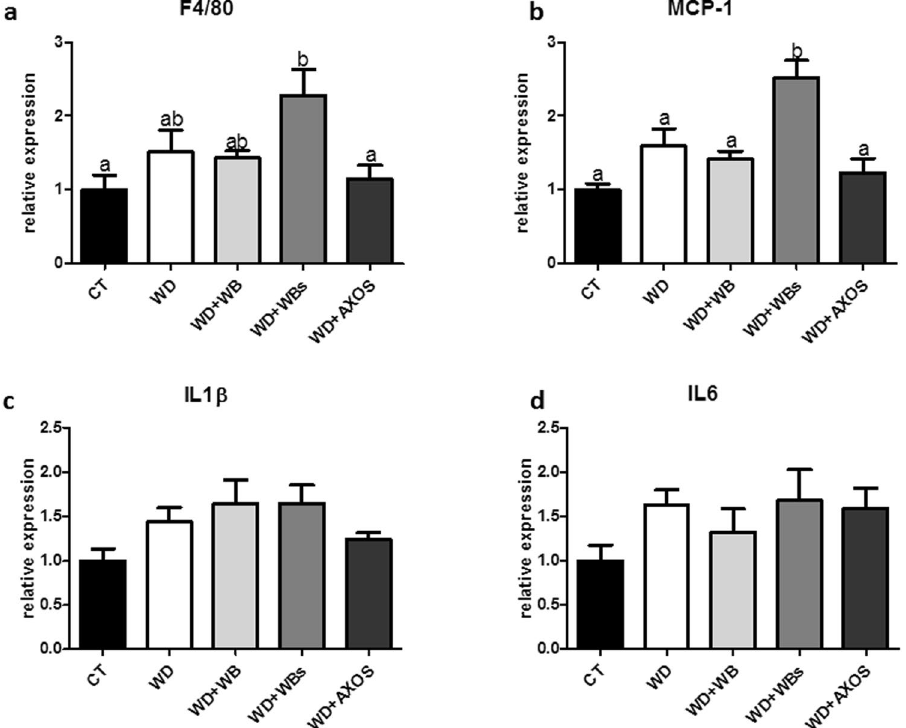
Figure 6. Inflammatory markers in visceral adipose tissue. Mice were fed a control diet (CT), a western diet (WD), a WD supplemented with 5% of wheat bran (WD + WB), a WD supplemented with 5% of wheat bran with reduced particle size (WD + WBs) or a WD supplemented with 5% of AXOS (WD + AXOS) for 8 weeks. Results are expressed as mean ± SEM (n = 6–9). Data with different superscript letters are significantly different at p < 0.05 (ANOVA).